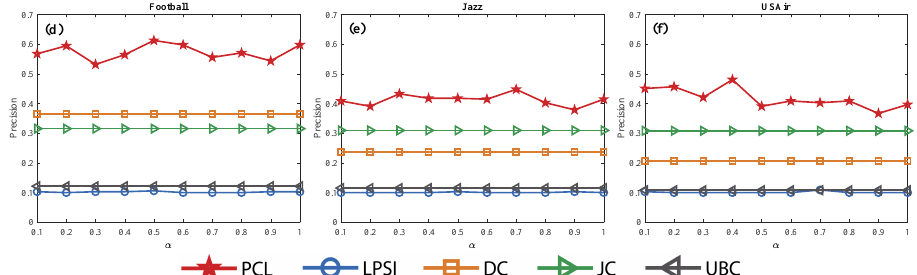
Figure 5. The relationship between sources localization precision and α ( β = − 1) with five methods in real networks. ( a – f ) represent the multiple sources localization performance in Karate, Lesmis, Adjnoun, Football, Jazz and USAir network respectively. The number of sources is s = 3 in all networks.